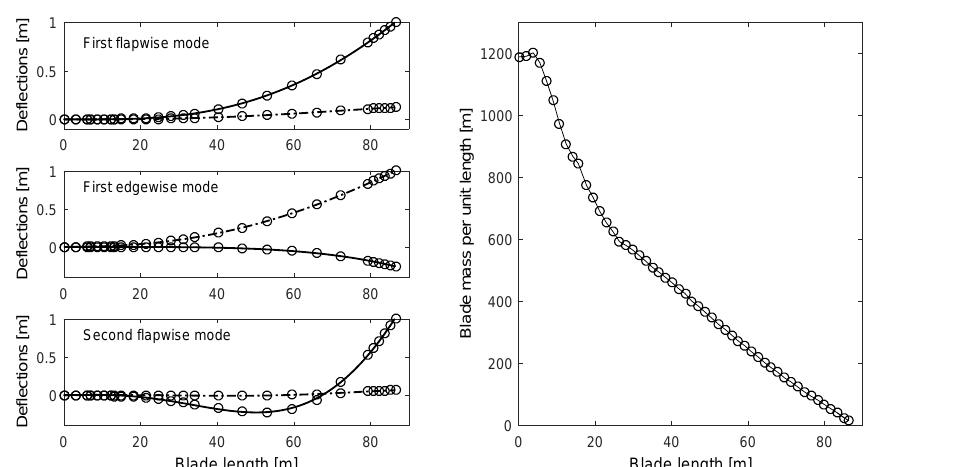
Figure 1. Illustration of the simple turbine model.